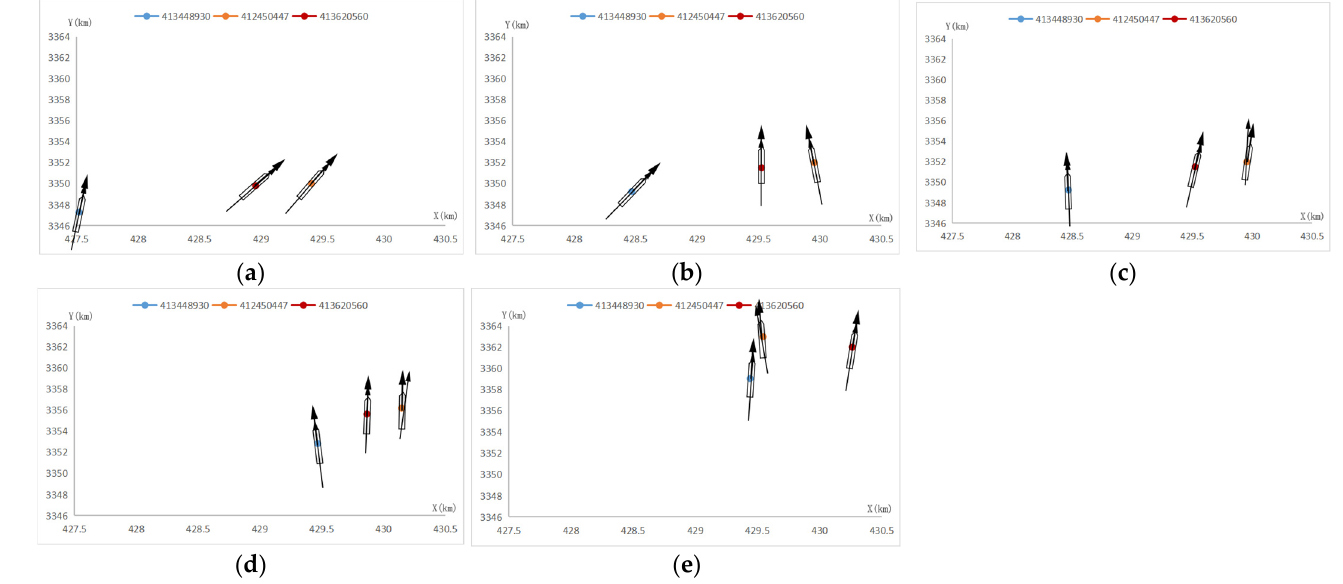
Figure 11. Position of three ships: ( a ) the three ships at 19:30; ( b ) the three ships at 19:40; ( c ) the three ships at 19:51; ( d ) the three ships at 20:00; ( e ) the three ships at 20:29.